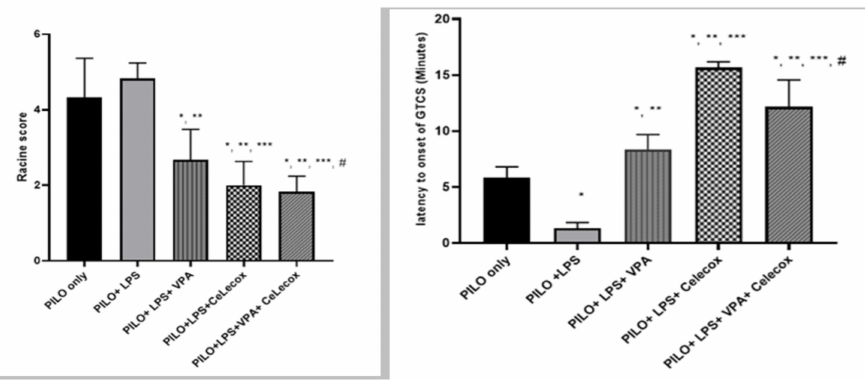
Figure 1. Effects of test drugs on Racine score and latency to Generalized Tonic-Clonic Seizure (GTCS) onset in rats subjected to Pilocarpine. Data were expressed as mean +/ − standard deviation. PILO: pilocarpine, LPS: lipopolysaccharides; VPA: Valproic acid, Celecox: celecoxib. Comparison between groups was made using One-way ANOVA test followed by Tukey’s multiple comparison test. * p < 0.05 comparison versus PILO only; ** p < 0.05 comparison versus PILO+LPS, *** p < 0.05 comparison versus PILO +LPS+VPA, # p < 0.05 comparison versus